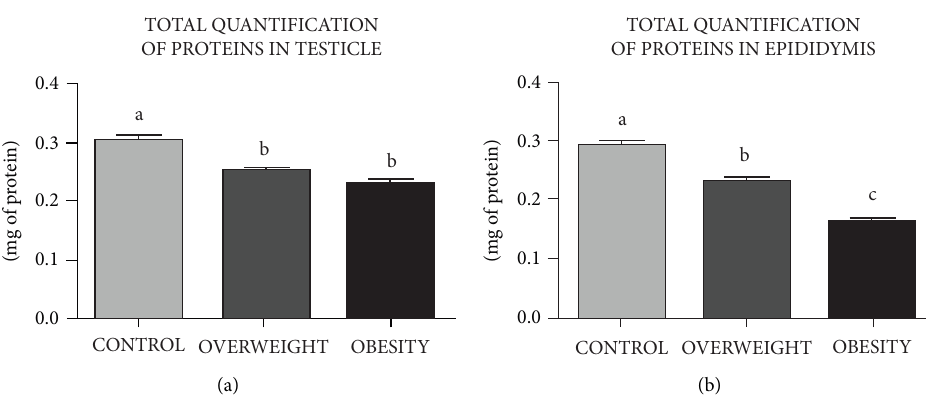
Figure 2: Amount of total soluble protein in testis and epididymis in Wistar rats fed for four weeks with regular chow (control group (CN)) or hyperlipidemic diets with 10% (overweight group (OW)) and 60% fat (obesity group (OB)). Bars represent mean ± SD. Letters indicate significant differences between groups, P < 0 . 05 (CN vs. OW vs.